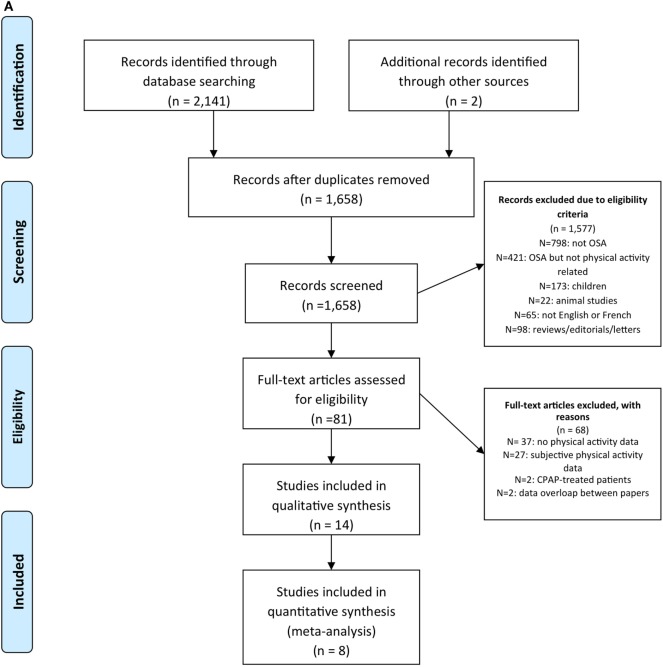
Prisma flow chart of articles identified and evaluated during the study selection process for (A) physical activity and (B) exercise training.